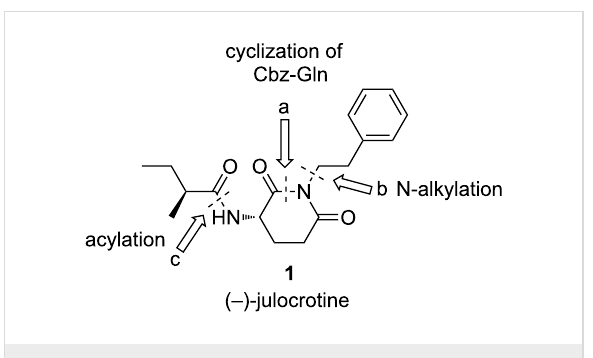
Figure 1: Retrosynthetic scheme for ( − )-julocrotine ( 1